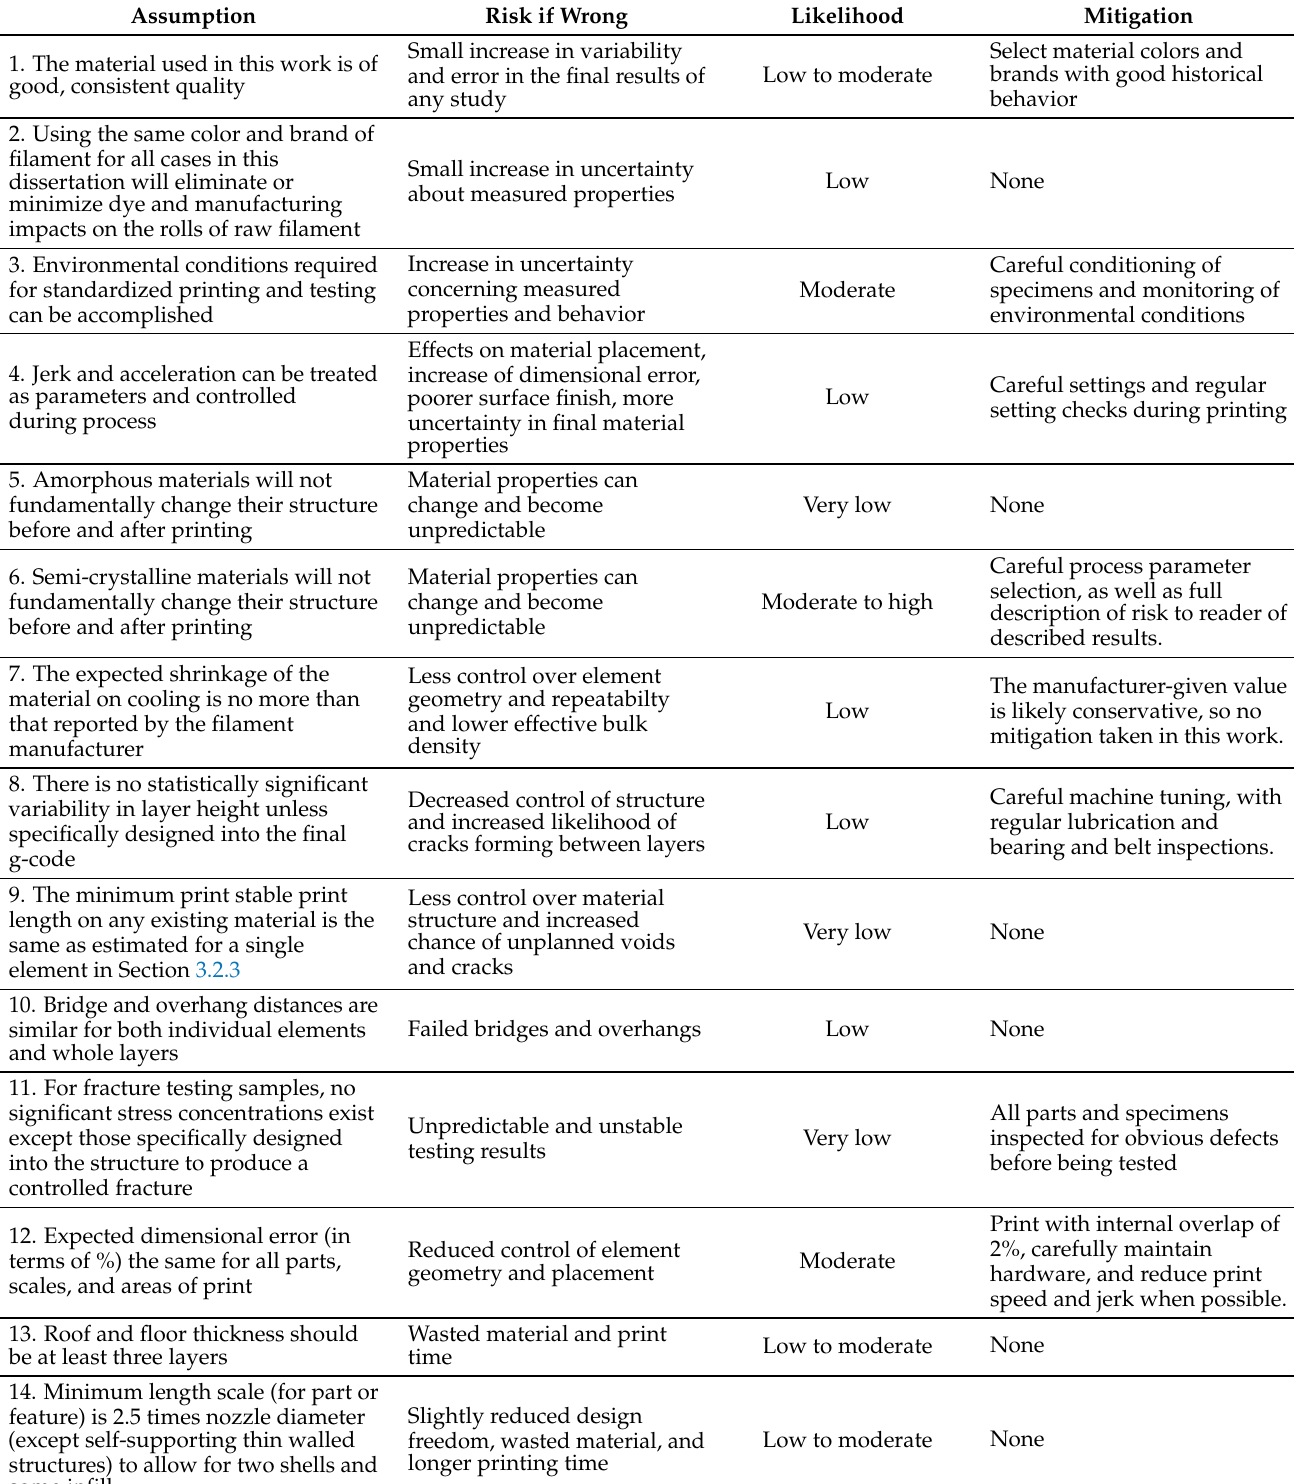
Table 6. Sensitivity analysis on assumptions for the presented constraint set to be applied to the work in this paper. If a mitigation strategy has been put in place for the work presented, it will be specified in the table. If not (mitigation not needed or not possible), the entry for that assumption will be